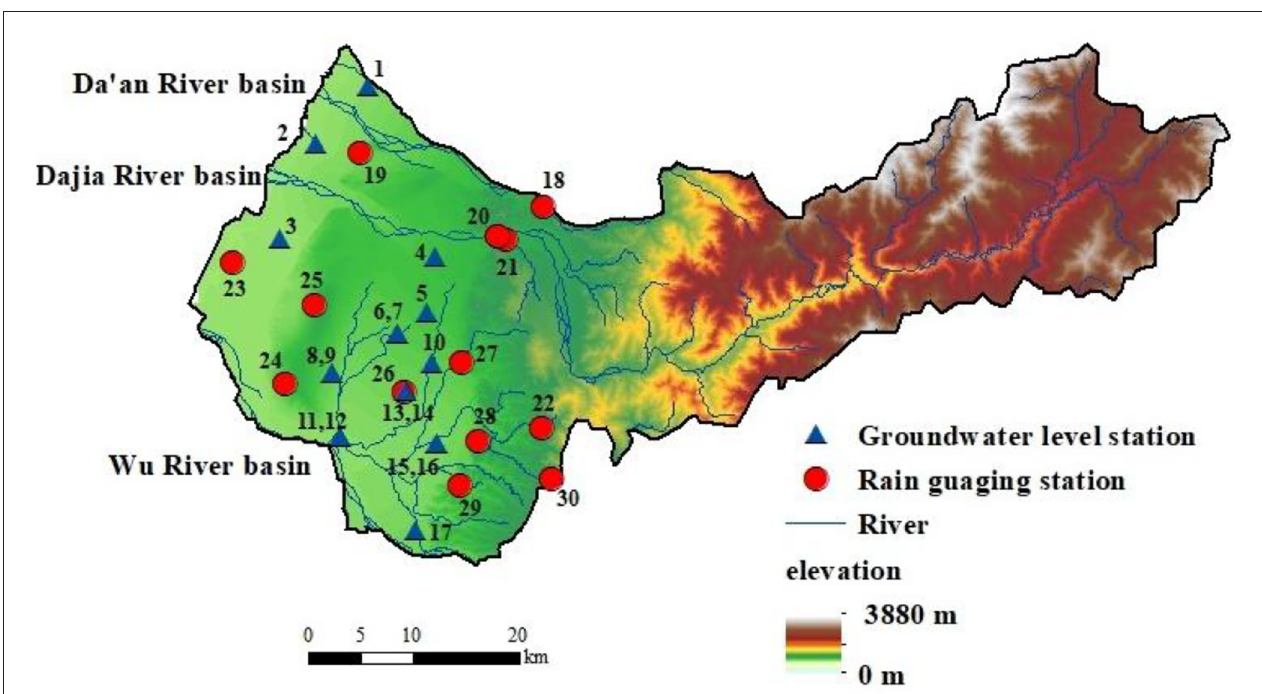
FIGURE 1 | Topography of study site and location of the rainfall stations and groundwater stations used in the study.